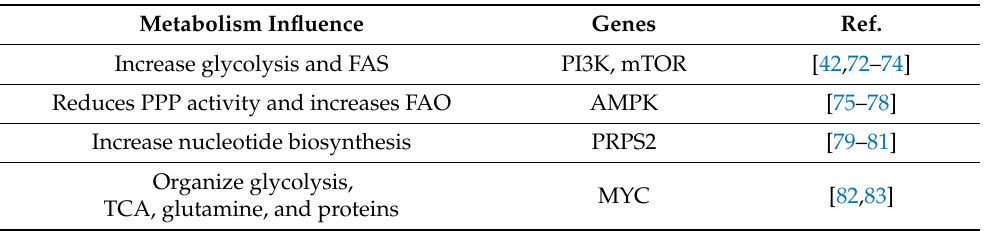
Table 1. Genetic mutations lead to B-cell lymphoma